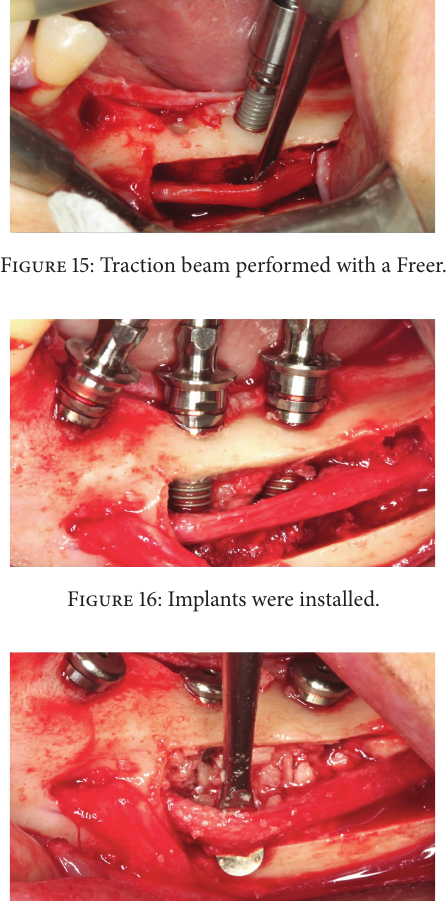
Figure 17: Filling in contact with implants (autogenous bone).